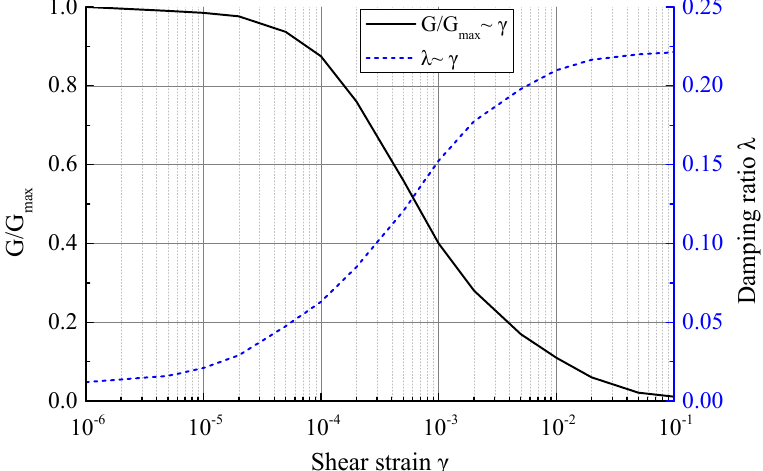
Figure 4. Reinforcement of the model structure components (mm): ( a ) Elevation of pier; ( b ) Side elevation of pier; ( c ) Mid − span cross-section of girder; ( d ) A − A section; ( e ) B − B section; ( f ) Pile section.